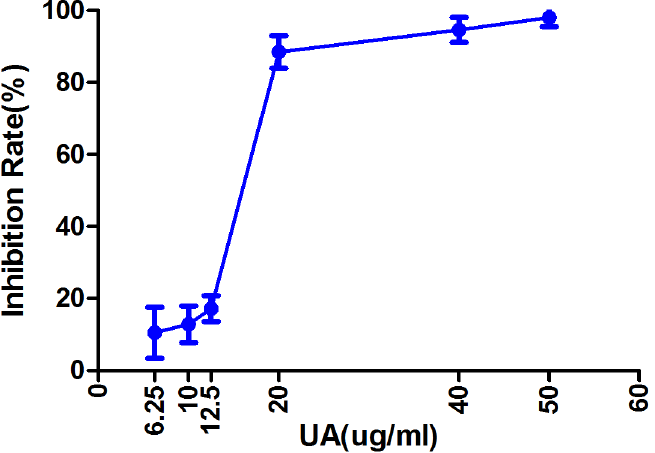
Fig 1. Cytotoxic effects of UA in BGC-823 cells. After 48h incubation with UA at the indicated concentrations, cytotoxicity was determined by the MTT assay. UA caused cytotoxicity in a dose-dependent manner, the IC 50 of UA for BGC-823 was 17.5ug/ml, and we defined 10ug/ml as a slight cytotoxicity (sub- cytotoxicity) ( < 15%)